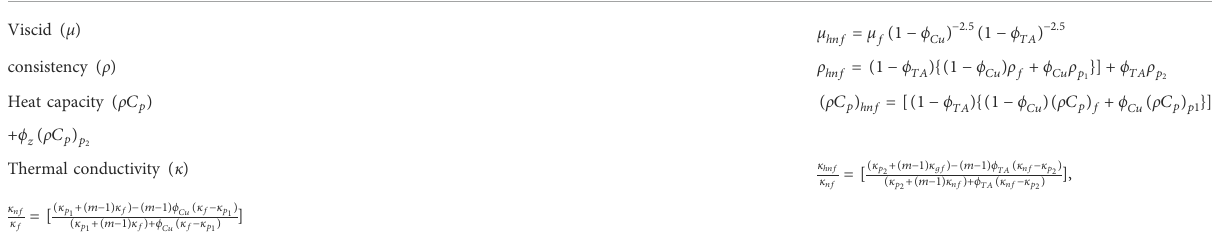
TABLE 2 Thermophysical properties of PEHNF. Aspect Hybrid nanoliquid